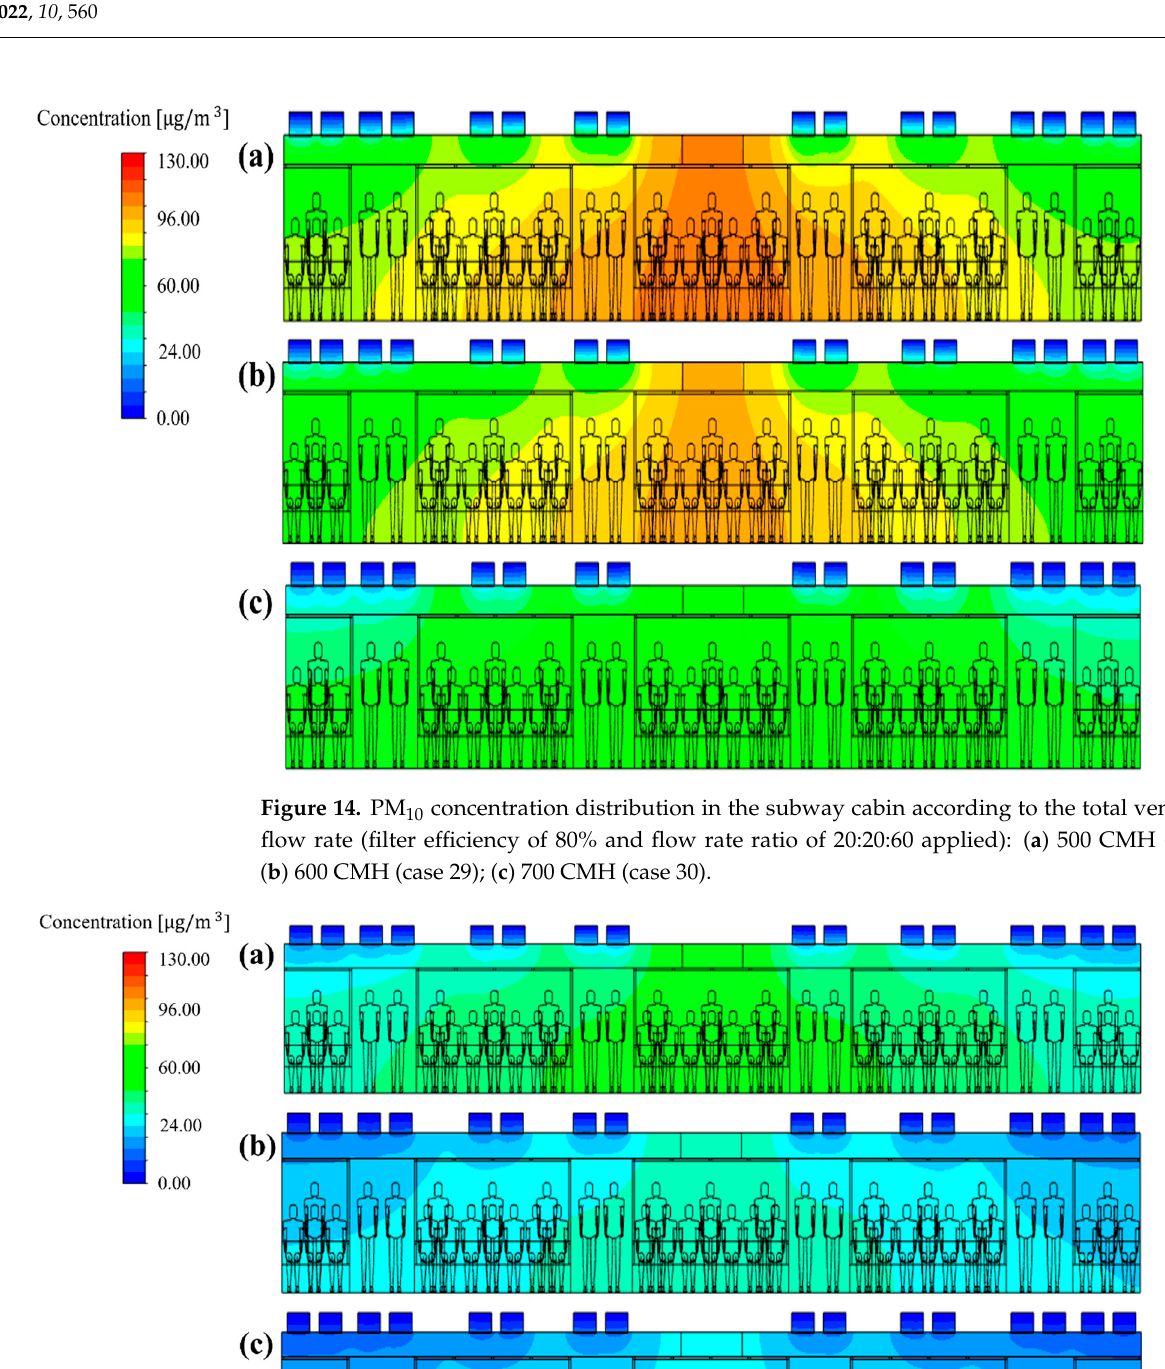
Figure 13. Average PM 10 concentration in the cabin at a fixed flow rate ratio of 20:20:60 (total venti- lation flow rate of 600 CMH applied for cases 27, 29, and 31, 700 CMH—for cases 28, 30, and 32; filter efficiency of 70% applied for cases 27 and 28, 80%—for cases 29 and 30, 85%—for cases 31 and 32).